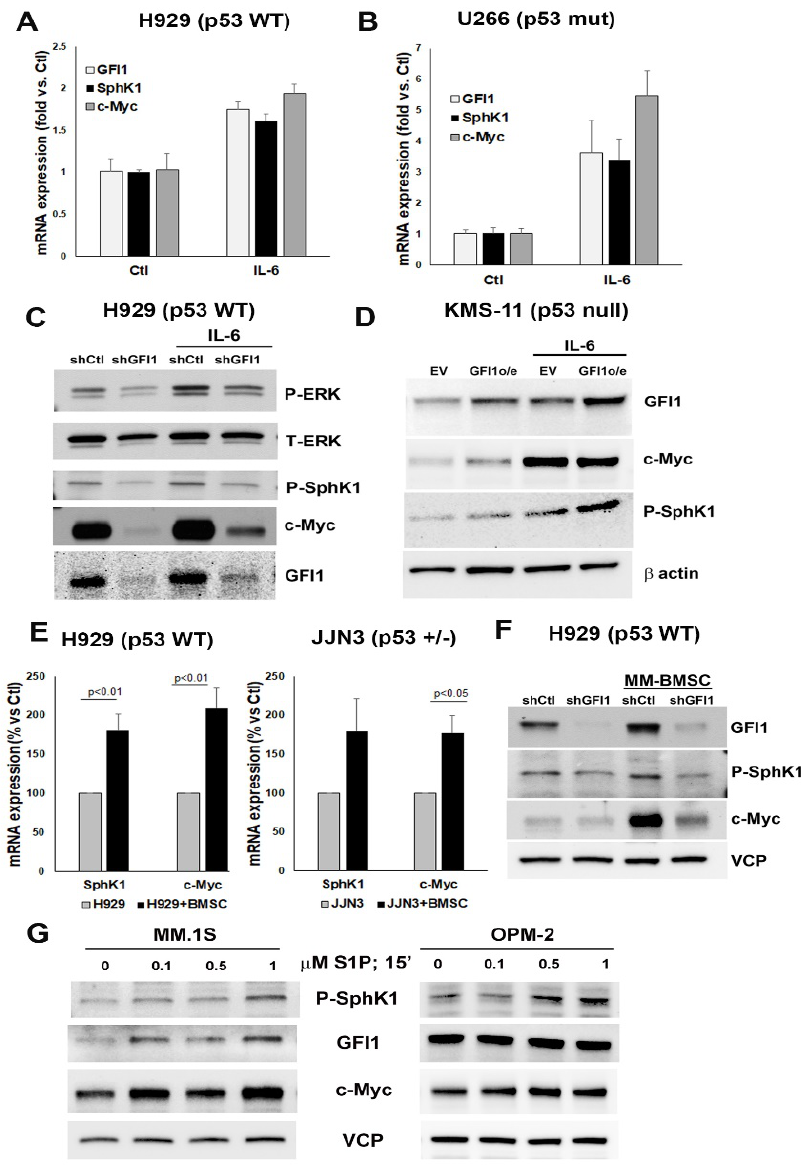
Figure 3. Microenvironmental factors activate the GFI1-SphK1-c-Myc axis for survival. GFI1, SphK1, and c-Myc mRNA expression detected by qPCR and expressed as fold change versus untreated control in MM cell lines H929 (p53 WT) ( A ) and U266 (p53 mut) ( B ) treated or not with IL-6 (5 ng/mL; 4 h), indicated proteins expression levels by WB (using total ERK1/2 (T-ERK1/2) and β actin [see Figure S6] as loading control) in H929 cells transiently knocked down using sh GFI1 and Sh-vector control ( C ), and in KMS-11 (p53 null) cells stably expressing GFI1 o/e and their EV controls (using β actin as loading control) ( D ) treated or not with IL-6 (5 ng/mL; 4 h); MM cells H929 (p53 WT) (left panel) and JJN3 (p53+/ − ) (right panel) were directly co-cultured for 24 h with bone marrow stromal cells (BMSC) obtained from MM donors (MM 3, 6, and 9 in Table S1). MM cells were harvested separately and SphK1 and c-Myc mRNA levels were measured by qPCR and compared with levels in MM cells alone ( n = 3) ( E ); GFI1, P-SphK1, and c-Myc protein expression by WB using VCP as loading control in H929 cells transiently knocked down by sh GFI1 and sh-vector control and co-cultured or not with MM patient derived BMSC (MM3 in Table S1) ( F ); GFI1, P-SphK1, and c-Myc protein expression by WB in MM.1S (p53 WT) (left panel) and OPM-2 (p53 mut) (right panel) treated for 15 min with the specified concentrations of S1P or vehicle control (ethanol) and normalized by VCP ( G ). Original WB data in Figure S6 ( C , D , F , G